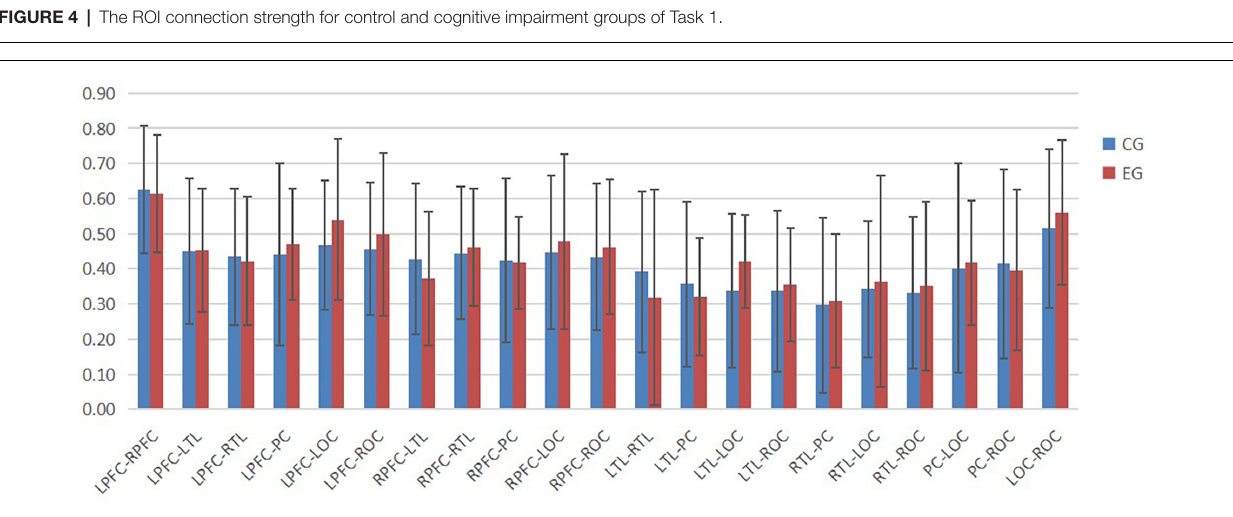
FIGURE 5 | The ROI connection strength for control and cognitive impairment groups of Task 2.